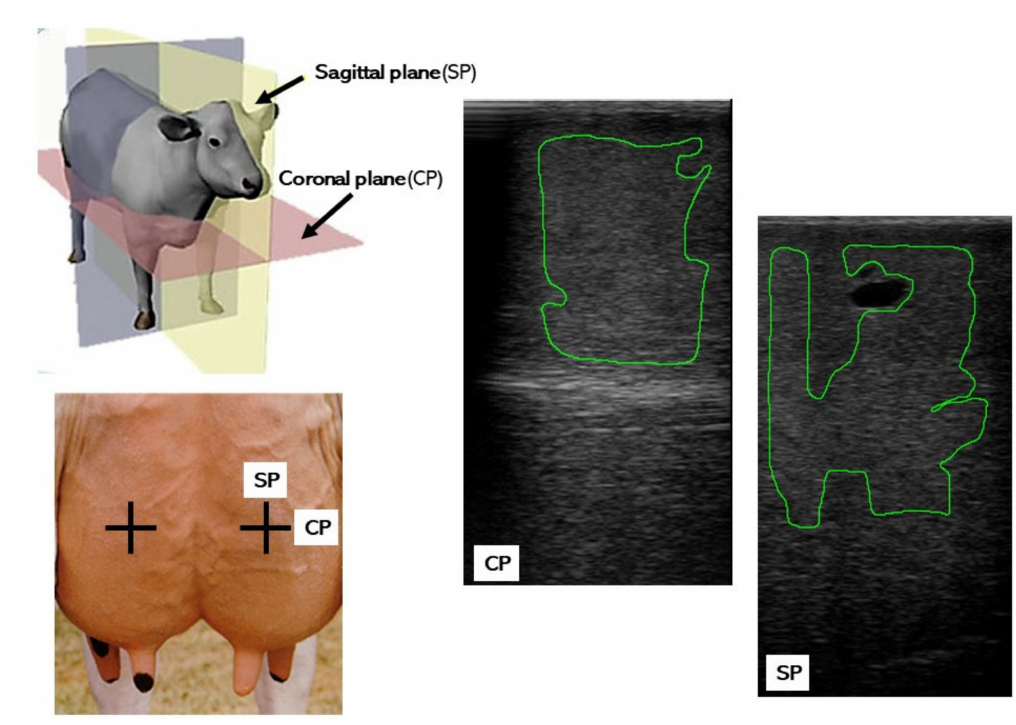
Figure 1. A general schematic of scanning planes and photographic reproductions of the mammary gland ultrasonograms from a Holstein-Friesian cow, obtained in a sagittal and coronal cross section, with outlines of polygonal areas of interest (green) excluding gland cisterns, blood vessels and artifacts, and used for computer-assisted analyses of mammary parenchyma